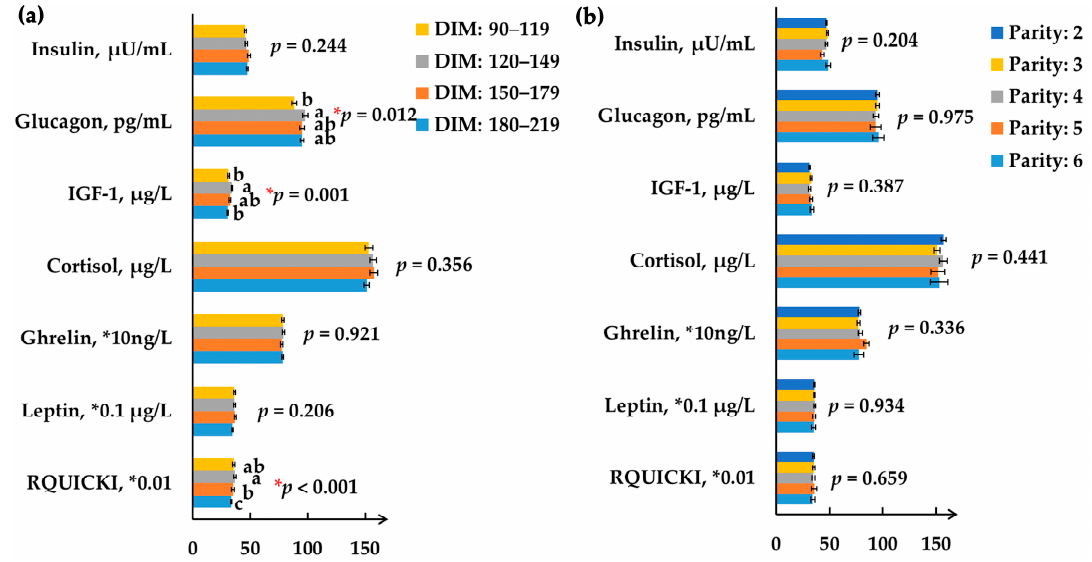
Figure 1. Effect of days-in-milk ( a ) and parity ( b ) on serum hormone profiles. ( a ) Description of days-in-milk effects on serum hormone profiles; ( b ) Description of parity effects on serum hormone profiles. Different color bars represent varying days-in-milk or different parities. Bar height represents the mean value of each individual hormone; the error bars represent the standard error of mean. IGF-1: insulin-like growth factor 1; RQUICKI: revised quantitative insulin sensitivity check index [10]. a, b Means within a hormone with different superscripts significantly differ ( p < 0.05).